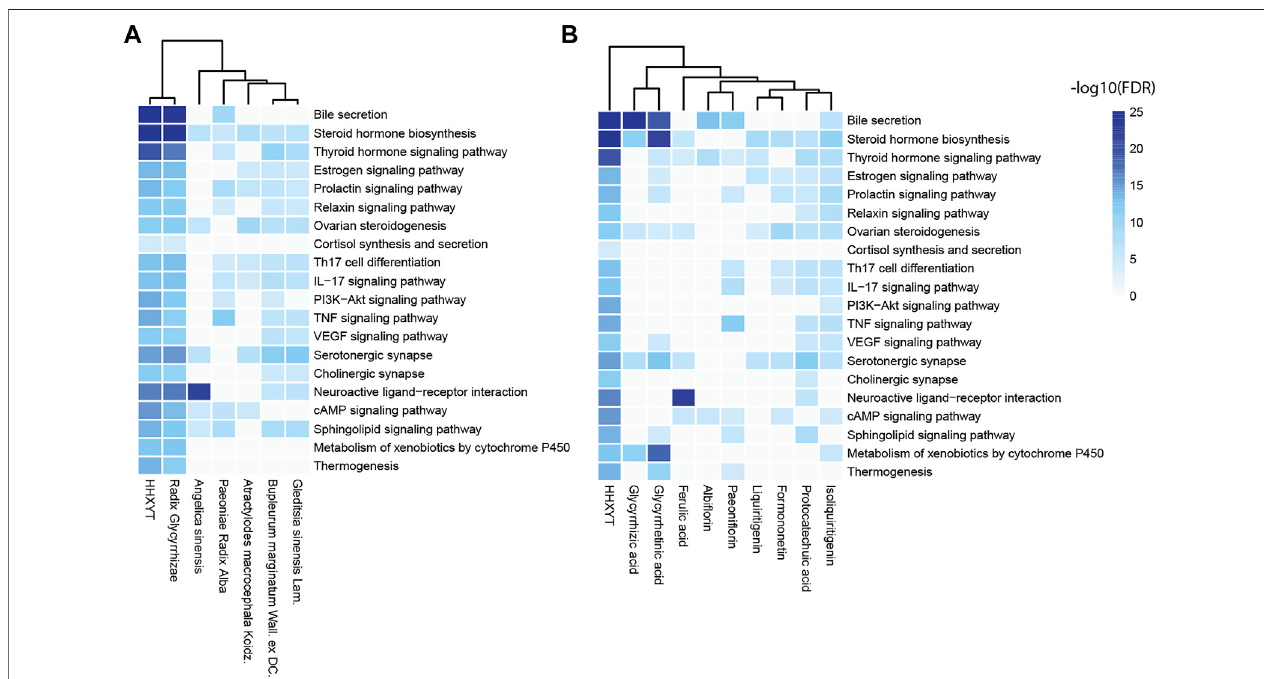
FIGURE 4 | KEGG pathway enrichment analysis for the targets of herbs and prototypes of HHXYT. Targets of 6 herbs (A) and 9 prototypes (B) from HHXYT were enriched in at least 3 of the top 20 KEGG pathways regulated by HHXYT, respectively.